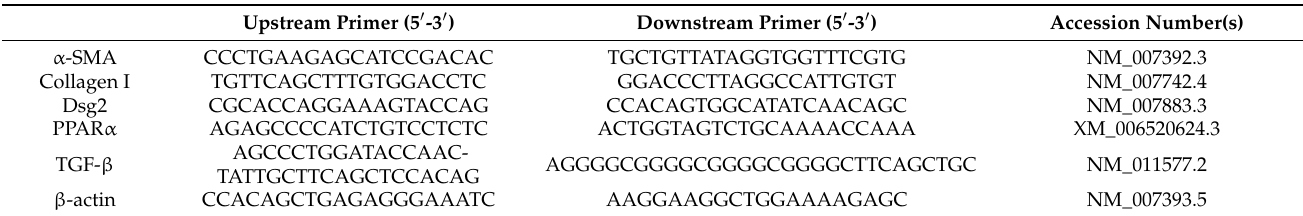
Table 1. List and sequences of primers used in RT-PCR